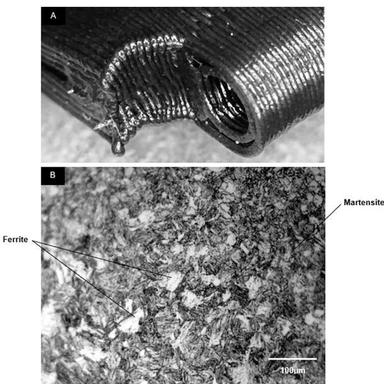
(A) The complex formation of an optimised structural section of MAG deposited stainless steel and (B) the metallographic structure produced after annealing at 1050 ◦C for 4 h and subsequent quenching.